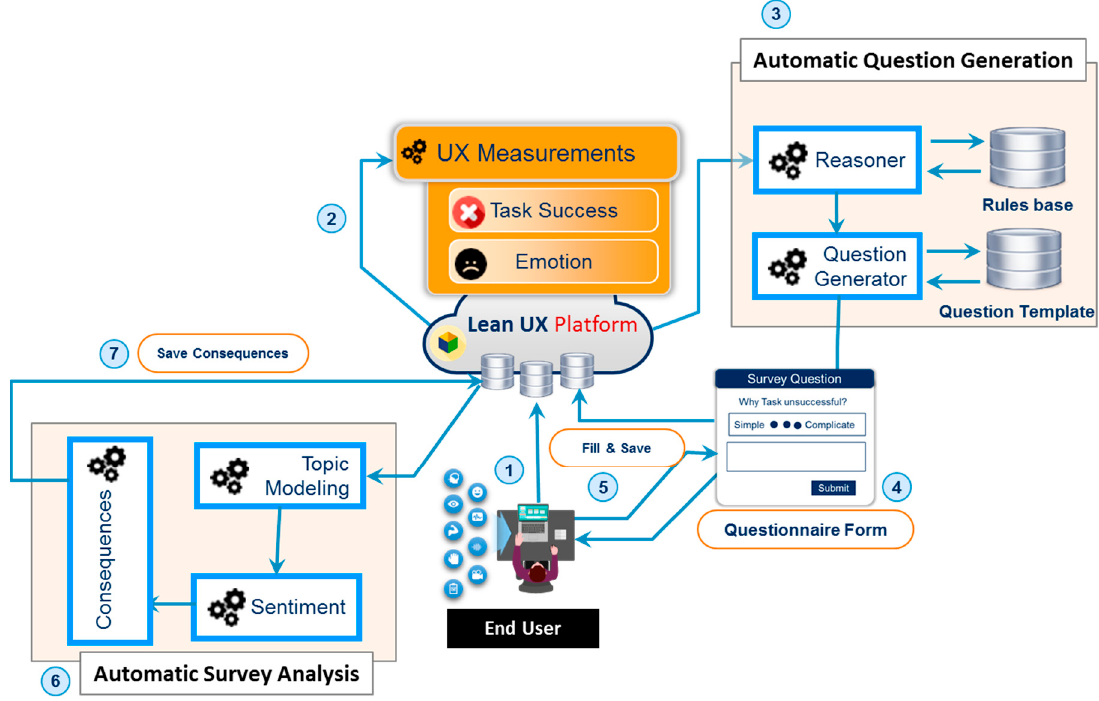
Figure 7. Survey workflow: triangulation of UX metric with self-reporting.